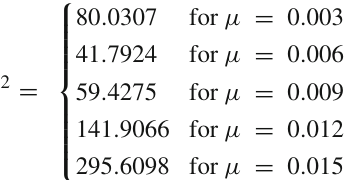
Fig. 7 Variation of in Eq. (61) against free parameter n